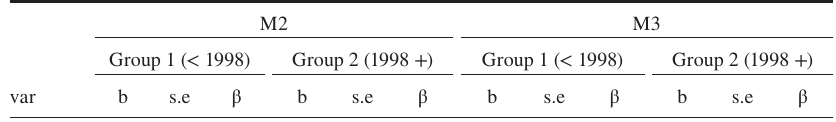
Testing Equilibrium Comparing Results by